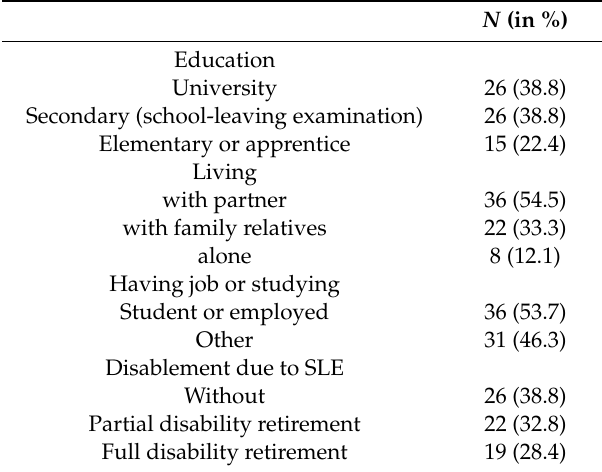
Table 1. Socio-demographic profile of systemic lupus erythematosus (SLE) patients (Slovakia 2012–2016, n = 67, female).